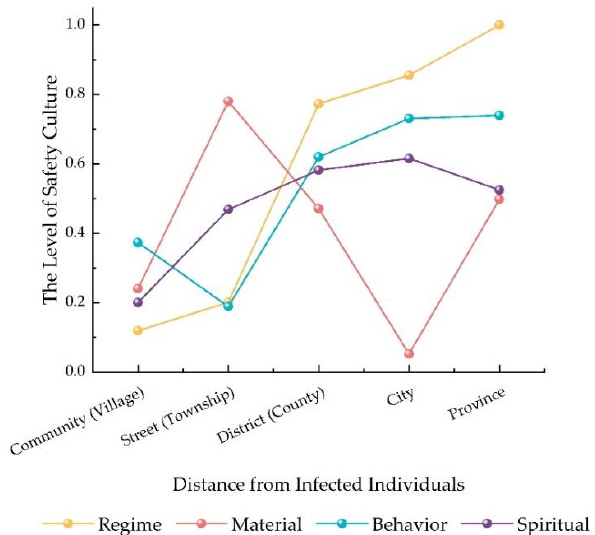
Figure 10. The trends of each dimension with different distance from COVID-19 cases.